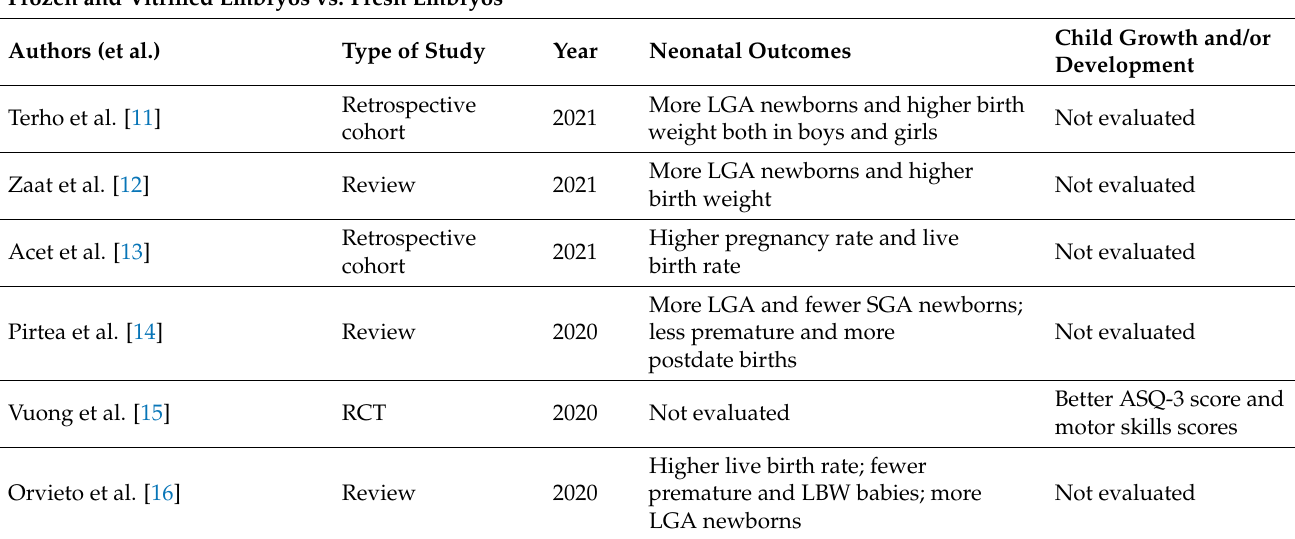
Table 1. Studies description regarding to the main findings on neonatal outcomes and child growth and/or development after transferring frozen versus fresh embryos.